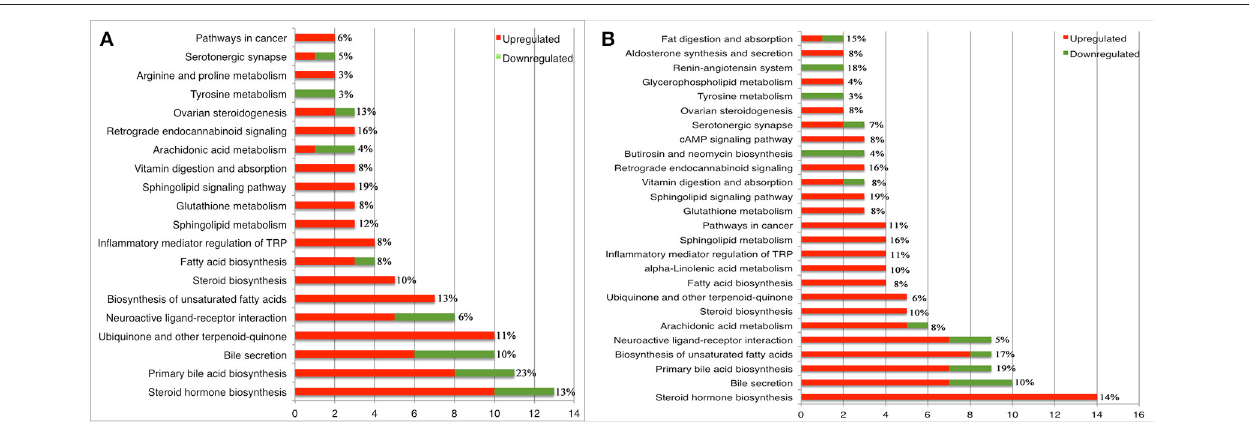
FIGURE 5 | Statistics and comparison of metabolic pathways during T. gondii infection phases. (A) Metabolic pathways of enriched metabolite ≥ 2 of acutely infected group vs. control. (B) Metabolic pathways of enriched metabolite ≥ 2 of chronically infected vs. control. Red and green metabolites indicate higher and lower concentrations, respectively. The x-axis denotes the number of differentially abundant metabolites. The y-axis indicates the name of metabolic pathways. The percentage represents coverage rate of the pathway, which is the differential metabolites/total metabolites in the